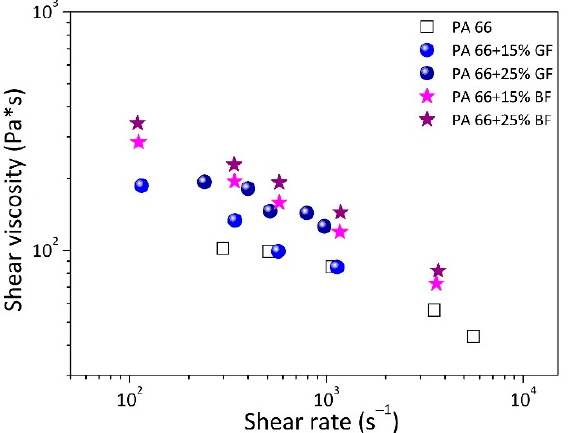
Figure 5. Real viscosity vs. shear rate evaluated at 270 °C for filled and neat PA 66.